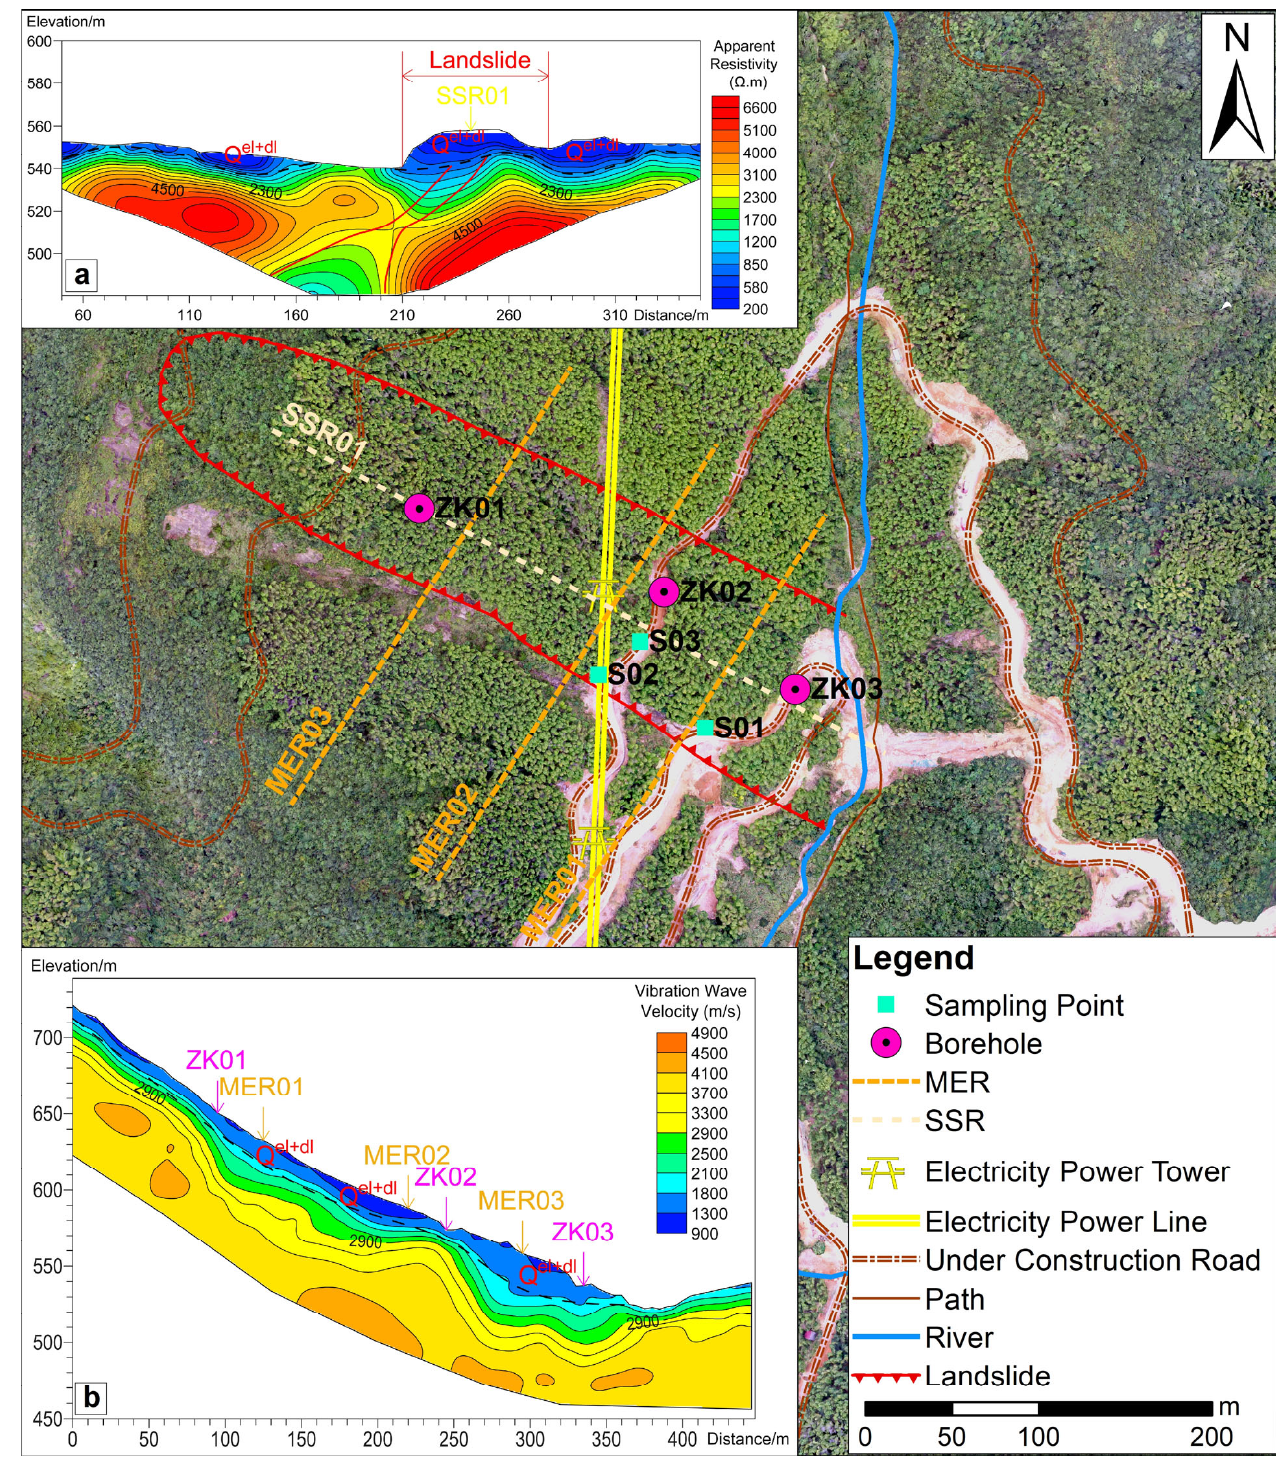
Figure 7. Shangfang landslide investigation plan. ( a ) SSR01 section. ( b ) MER01 section.